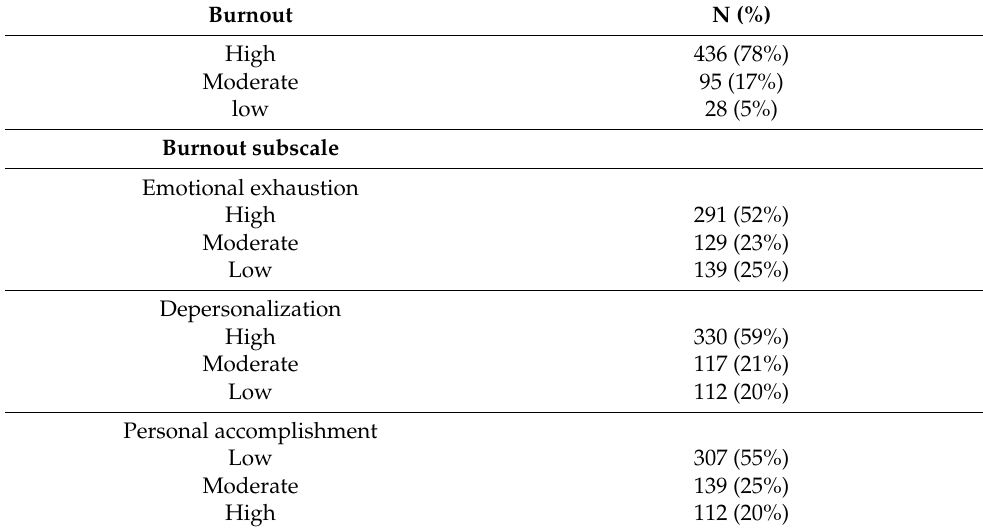
Table 2. Prevalence of burnout among RT students and interns during clinical training (n =